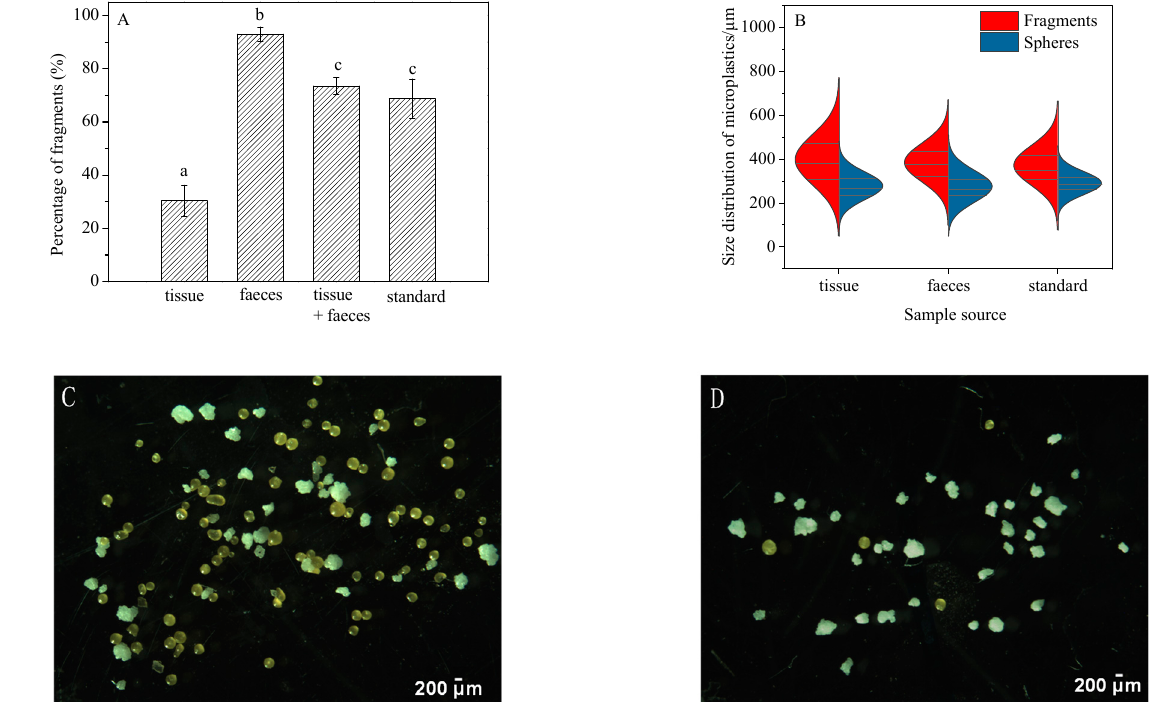
Figure 5. Shape ( A ) and size ( B ) distribution of microplastics in different media during the 21-d exposure. Typical photographs of typical extracted microbeads in tissue ( C ) and feces ( D ) over the 21-d exposure are shown. Differences between groups were analyzed for significance using Tukey’s multiple comparison test. Different letters above columns in subgraph ( A ) indicate significant differences (ANOVA, p < 0.05). Straight lines in subgraph ( B ) show medians and interquartile. No significant differences in the size of fragments and spheres exist in Figure 5B using Tukey’s multiple comparison test (ANOVA, p > 0.05).